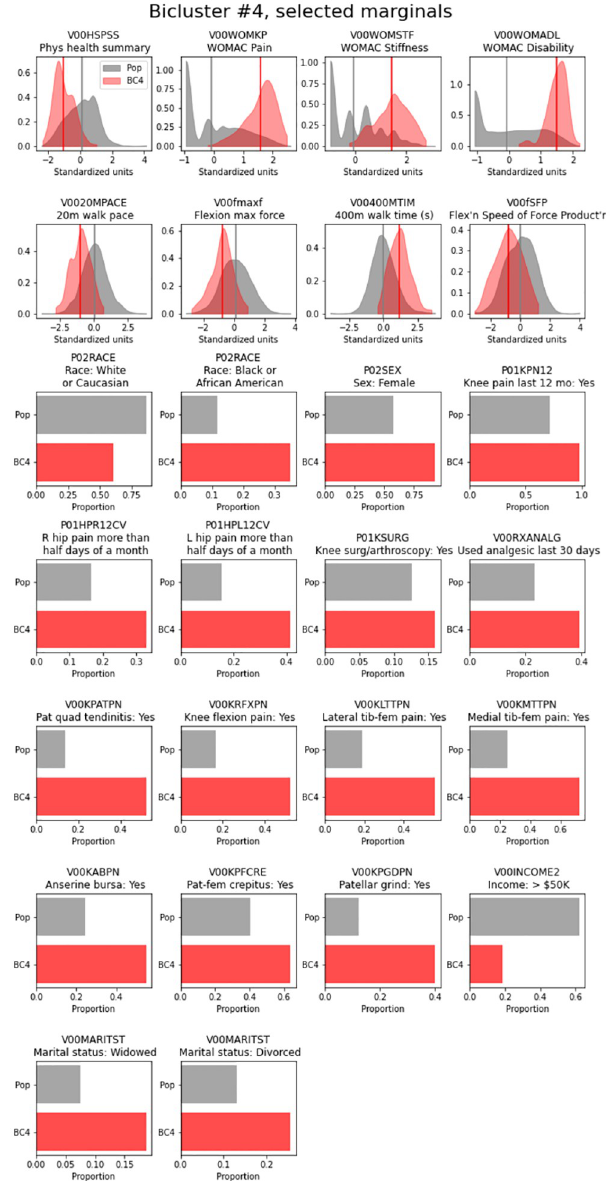
Fig 2. Distribution of top features for bicluster 4 (all knees). Marginal plots of key features for bicluster 4 are shown, with the distribution for the overall cohort of knees in gray and the distribution of each feature in bicluster #4 shown in red; vertical lines indicate the mean value for each